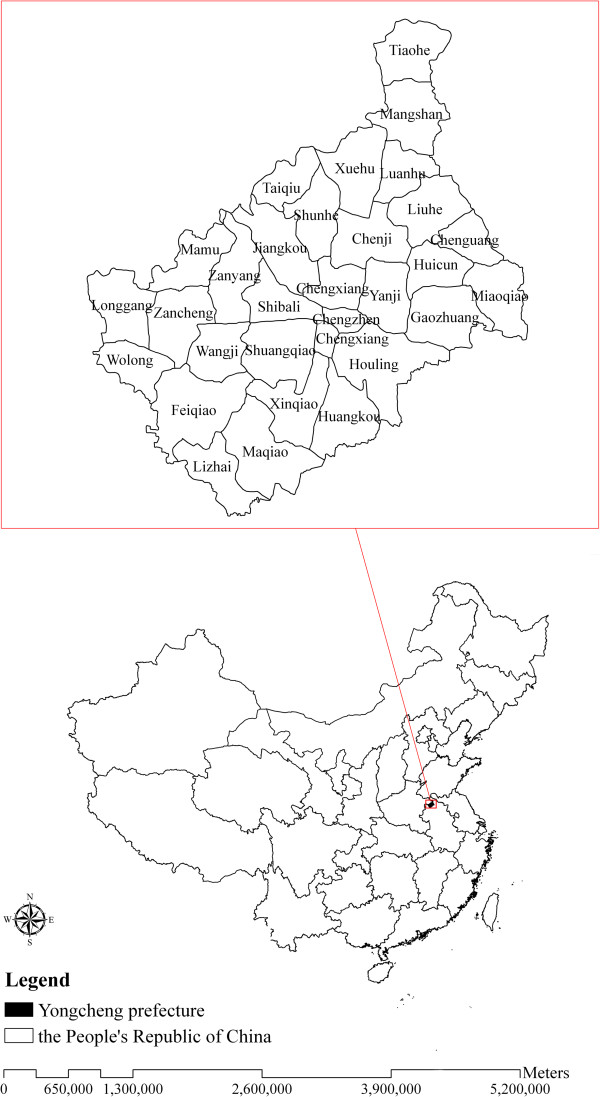
Location of Yongcheng prefecture in China.